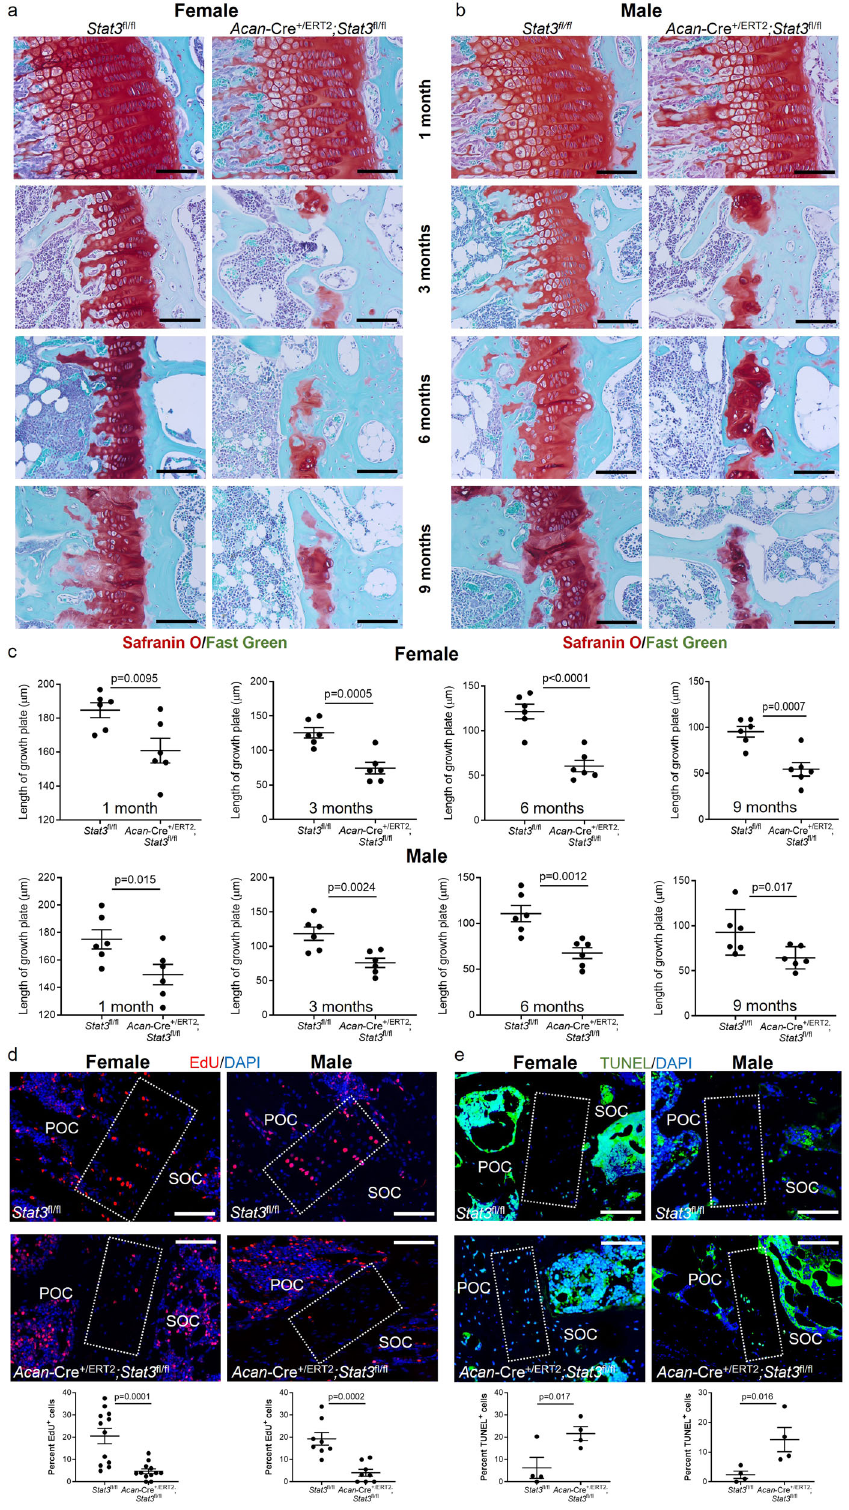
Fig. 3 Postnatal loss of Stat3 in chondrocytes decreases proliferation and increases apoptosis. Proximal tibial growth plates were greatly reduced in thickness following deletion of Stat3 at P2/P3 in ( a , c ) female and ( b , c ) male mice. Beginning at 3 months, growth plate fusions were observed with replacement by trabecular bone. Scale bars equal 50 µ m. d EdU was injected intraperitoneally for 4 days before analysis of mice at 3 months of age. EdU + cells in the proximal tibial growth plate were scored. e Apoptosis of chondrocytes in the proximal tibial growth plate (3 month old) was detected by TUNEL. Boxed regions indicate the growth plate. For each group, n = 6. Scale bars = 50 µ m. POC primary ossi fi cation center, SOC secondary ossi fi cation